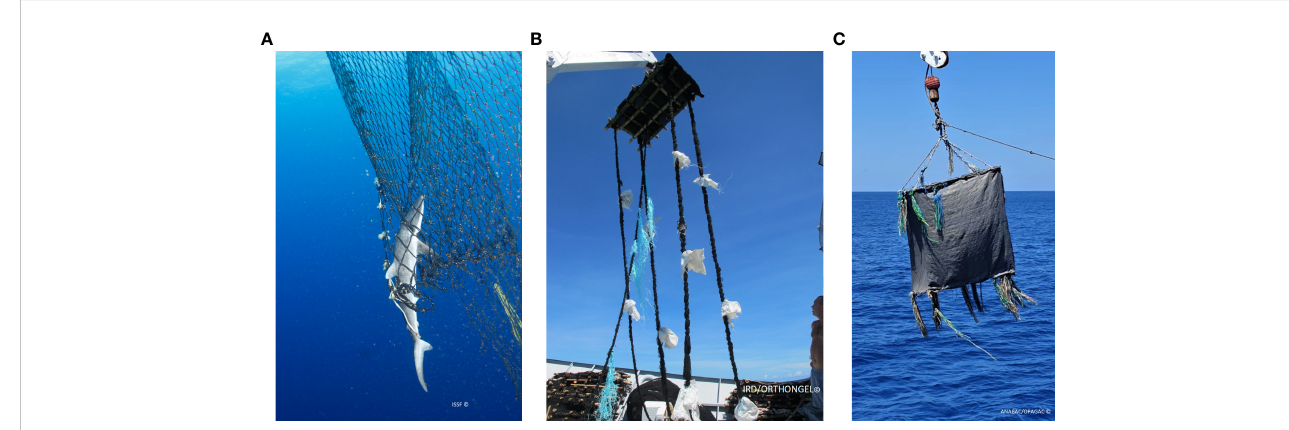
FIGURE 3 Transition process from traditional entangling dFADs to non-entangling dFADs with zero netting, (A) Shark entangled in the tail of a traditional high entanglement risk dFAD constructed with large mesh open panels, (B) dFAD prototype tested in 2013 by the French fl eet with net tied up into bundles to minimize entanglement risk, (C) non-entangling dFAD employed in the Indian Ocean built with canvas and biodegradable rope attractors and no netting